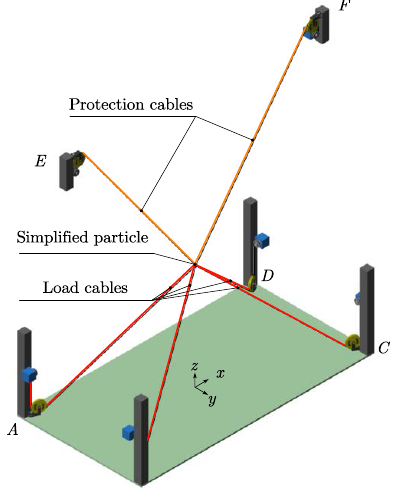
Figure 10. Simulation model.